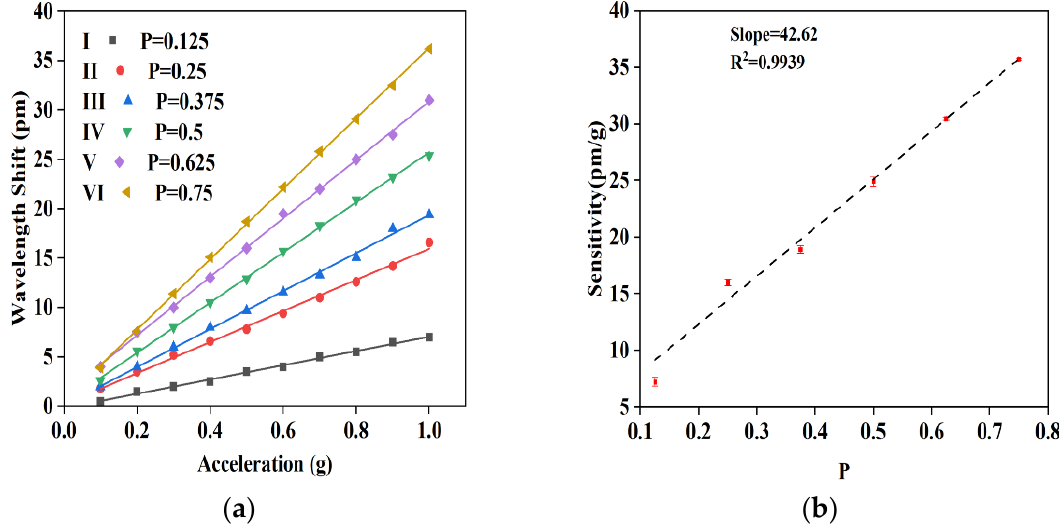
Figure 5. ( a ) Linear response capability of accelerometers 1–6 under a sinusoidal excitation signal with a vibration frequency of 100 Hz and vibration acceleration from 0.1 to 1 g. ( b ) The relationship between sensitivity and P.